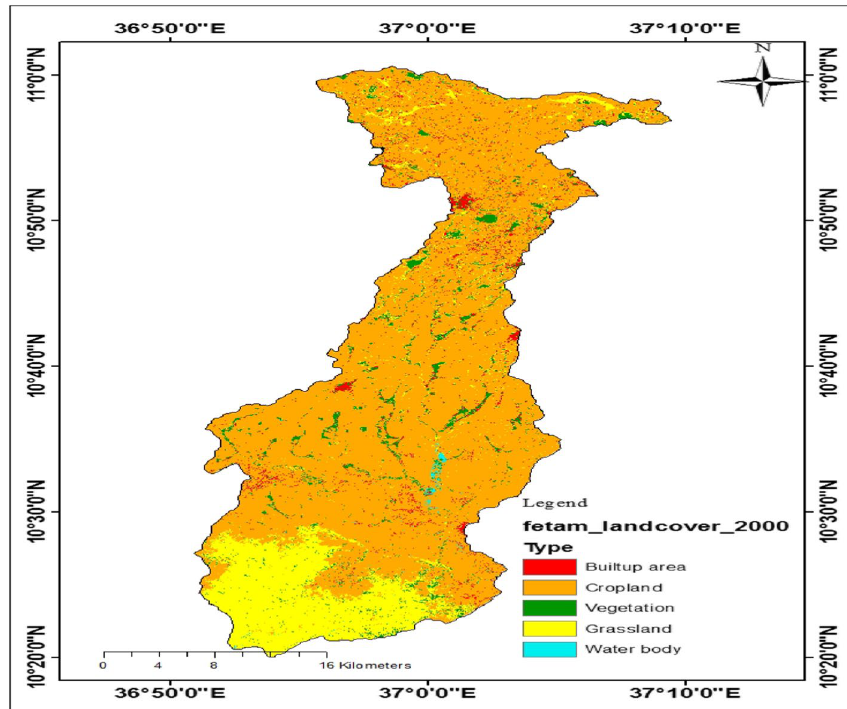
Fig. 7 A map of land usage and land cover in the year